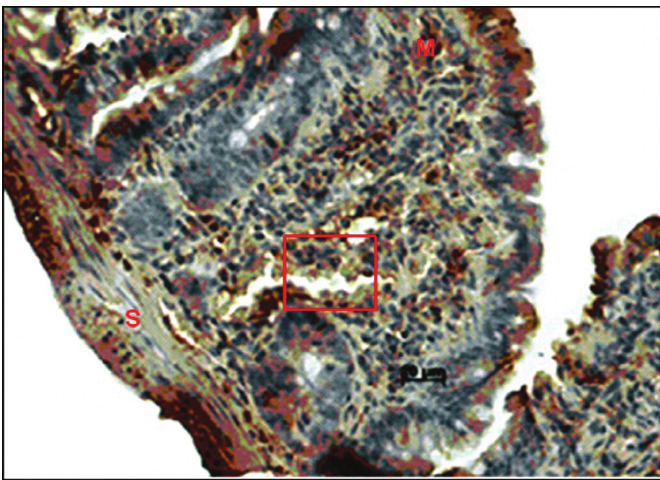
FIGURE 3 - Immunohistochemical analysis of the HBO /I-R/HBO group V- vilosity, M - mucosa, S- serosa, - CD34+ markers